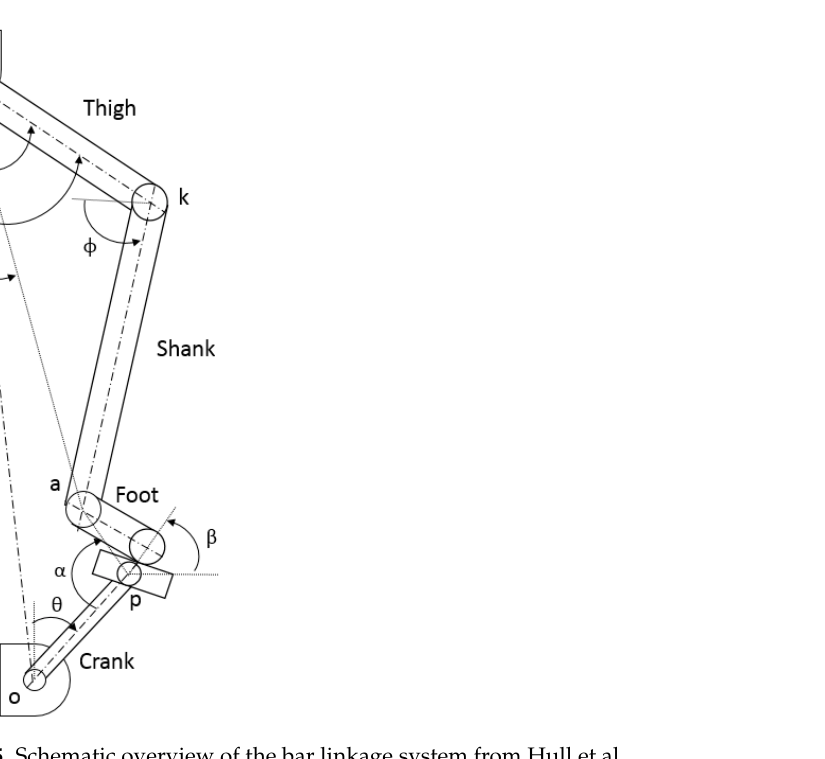
Figure 5. Schematic overview of the bar linkage system from Hull et al.